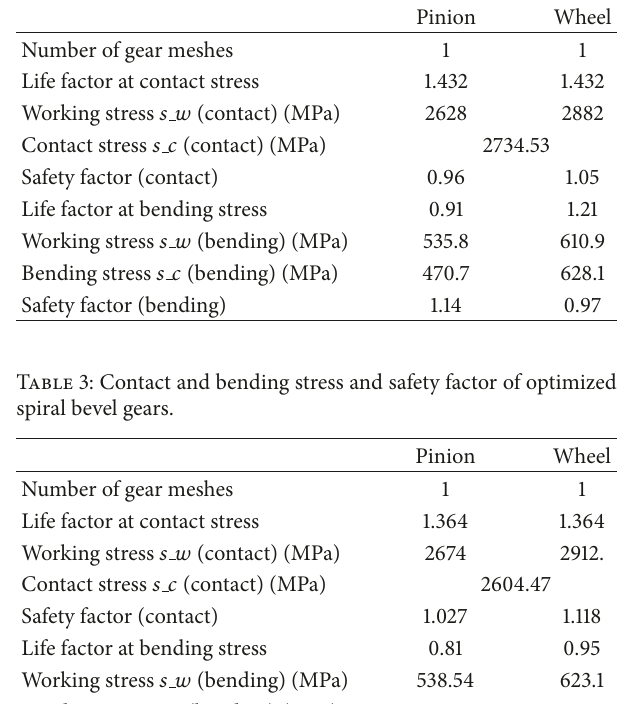
Table 2: Contact and bending stress and safety factor of original spiral bevel gears.